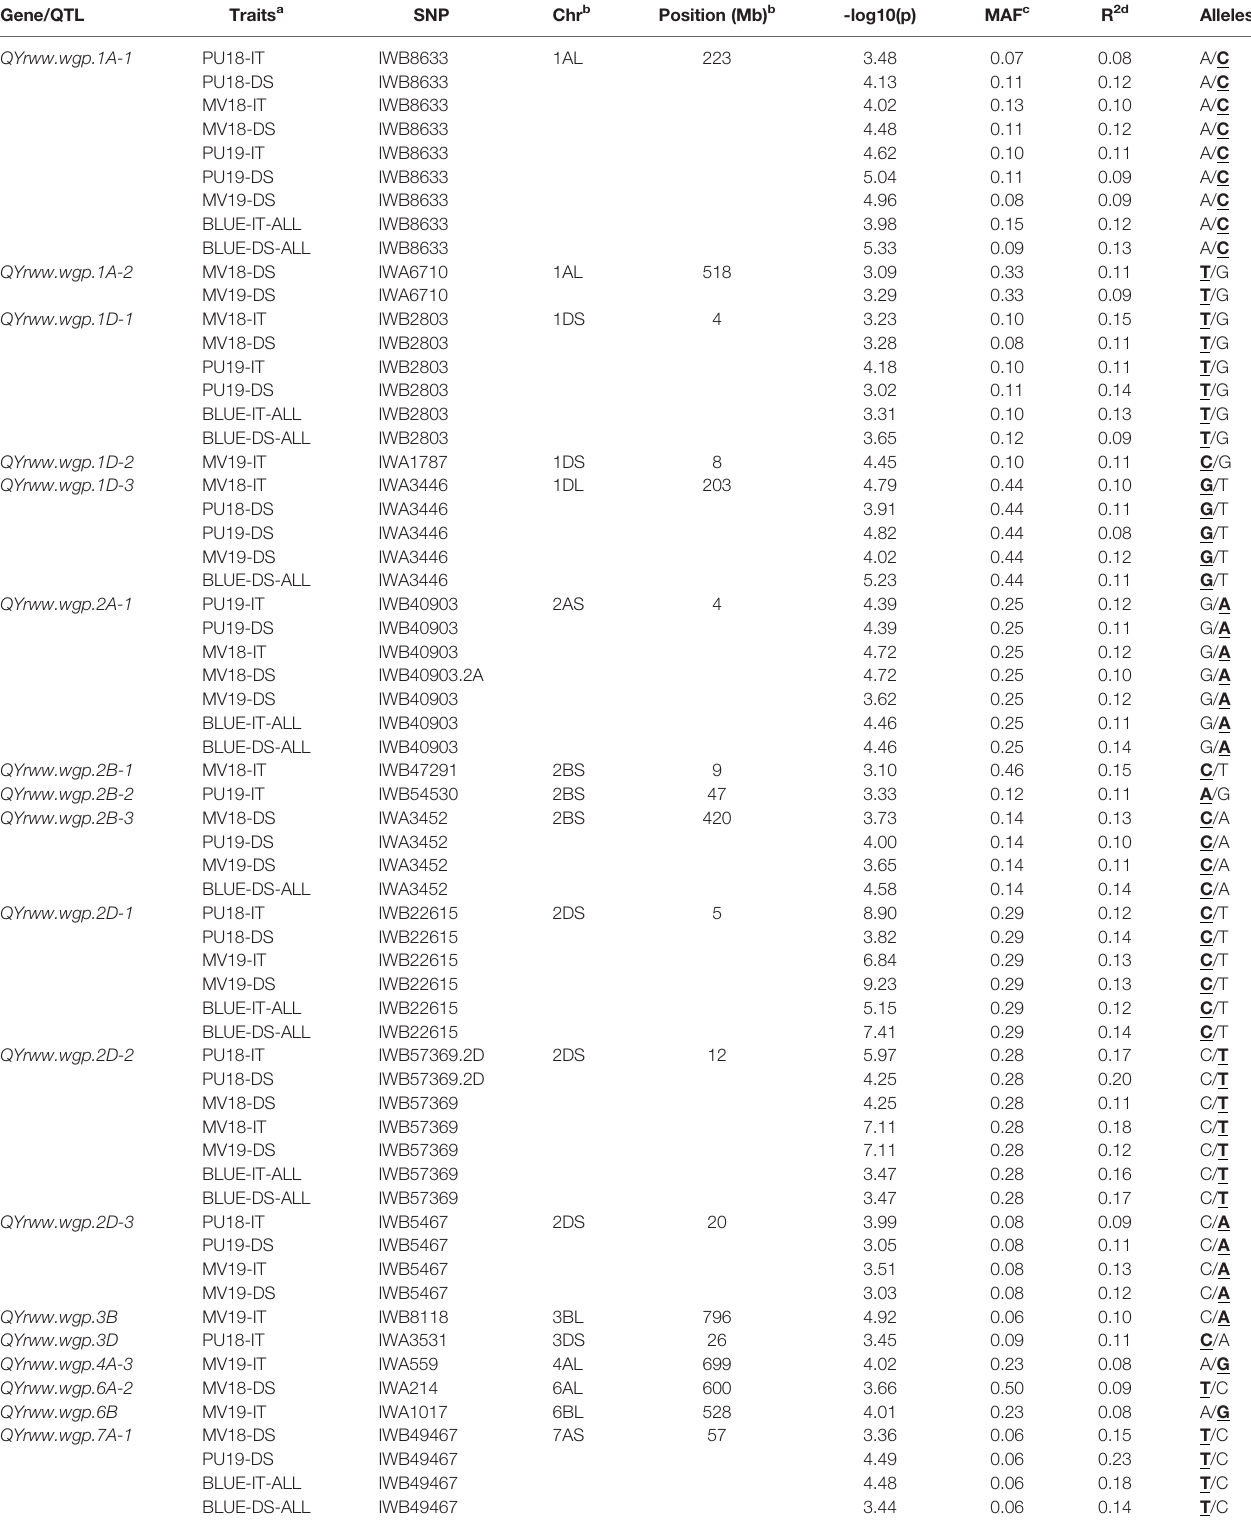
TABLE 3 | Resistance genes or QTL identi fi ed in the winter wheat panel associated with stripe rust reactions evaluated at the adult-plant stage in fi eld environments under natural infection of Puccinia striiformis f. sp. tritici . Gene/QTL Traits a Alleles e